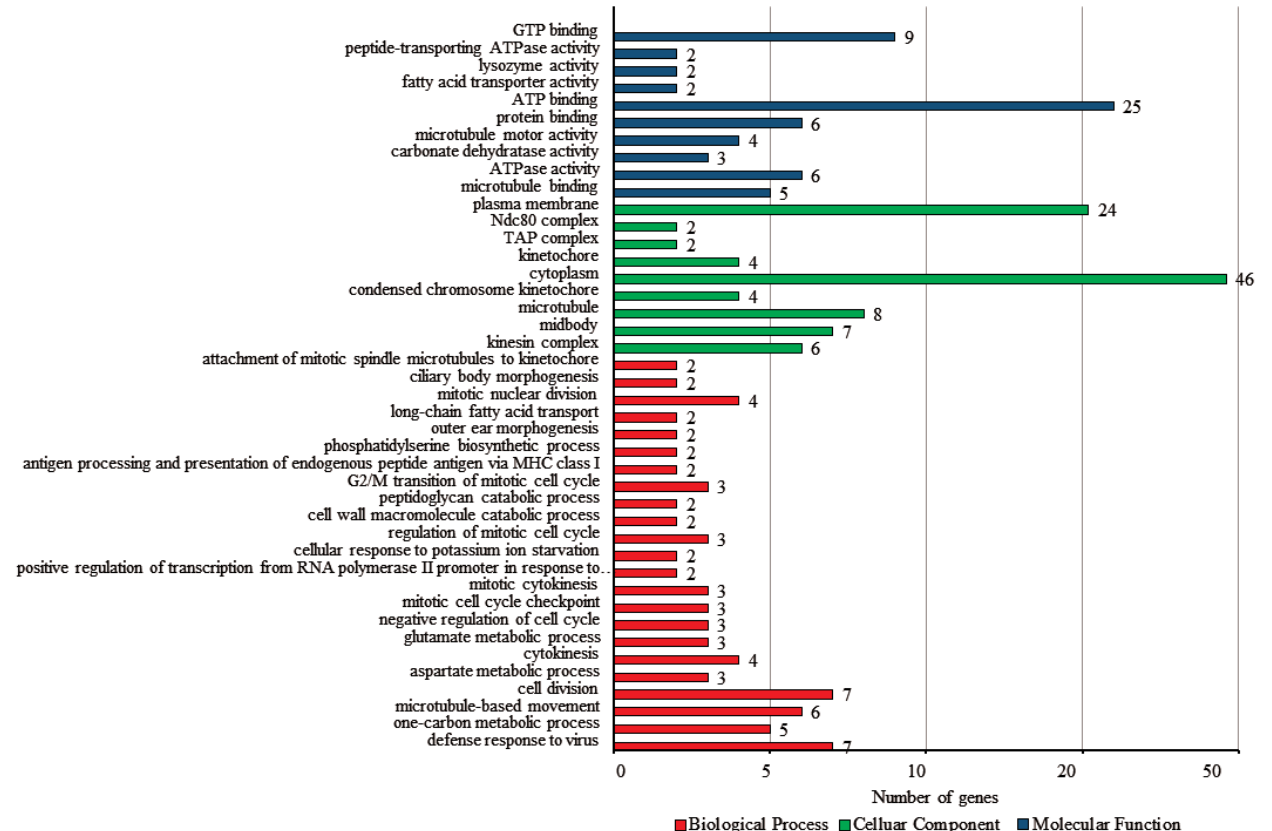
Figure 4. Gene ontology (GO) classification of differential expressed genes